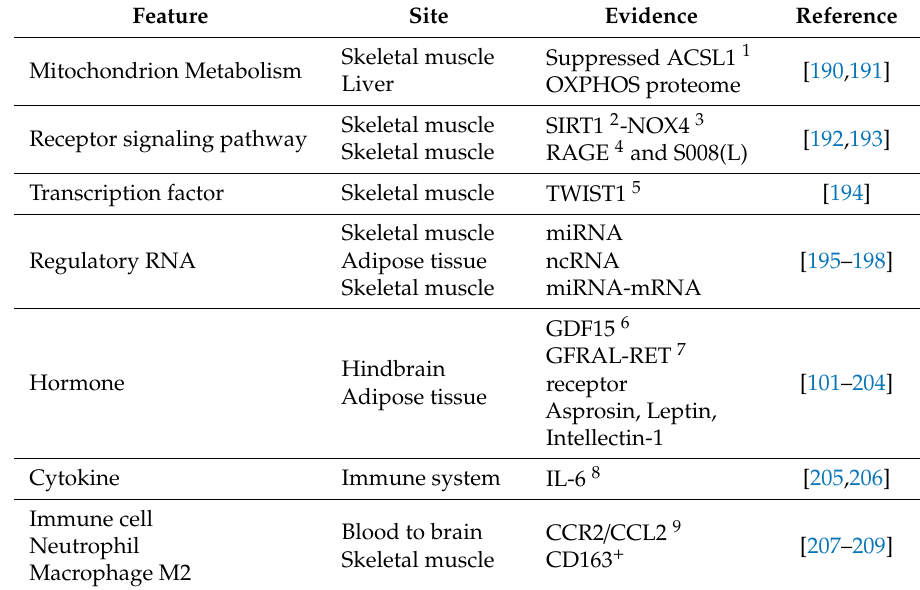
Table 4. New insights into cancer